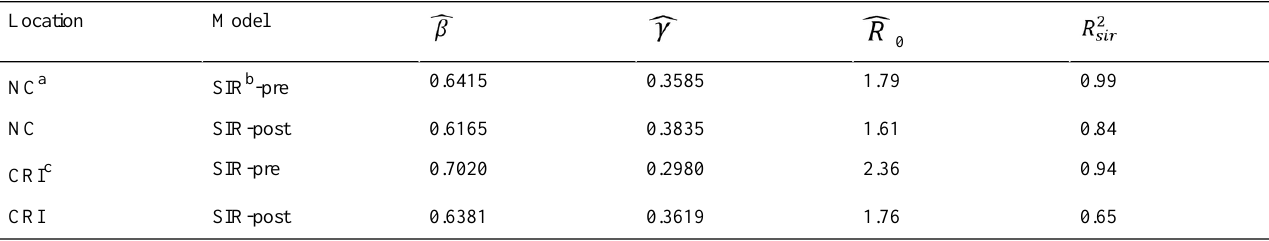
Table 1. Summary table of model fit for SIR-pre and SIR-post models in NC and the